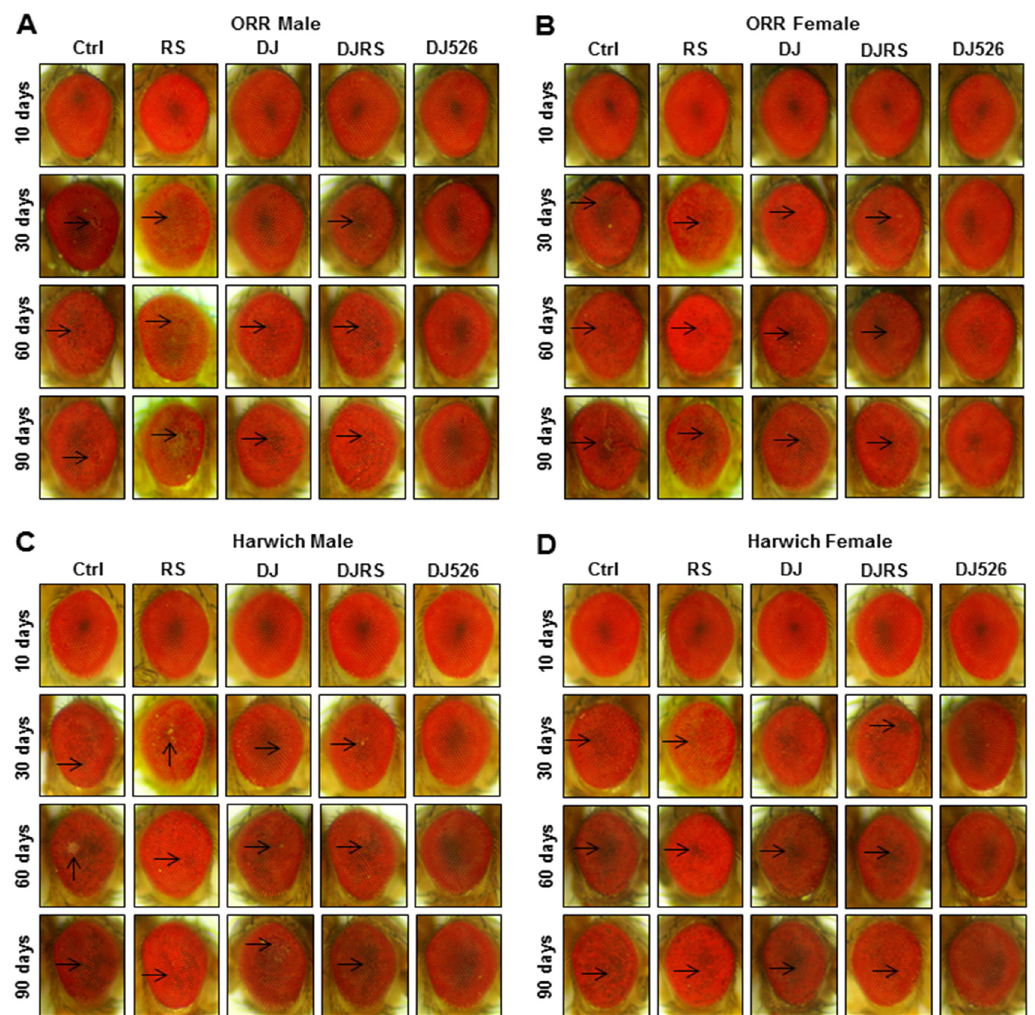
Figure 4. The resveratrol rice DJ526 suppressed the developmental eye defects in D. melanogaster . ( A ) ORR males, ( B ) ORR females, ( C ) Harwich males and ( D ) Harwich females with age progression. Ctrl represents standard cornmeal medium; RS represents cornmeal medium supplemented with resveratrol at 31.54 μ g/L, the equivalent amount of resveratrol found in the DJ526 media; DJ represents the medium in which 50% of cornmeal was replaced with Dongjin rice; DJRS represents the medium in which 50% of cornmeal was replaced with Dongjin rice and supplemented with resveratrol at 31.54 μ g/L, and DJ526 represents the medium in which 50% of the cornmeal was replaced with the resveratrol rice DJ526 (Table S1). Light microscopy studies of the Drosophila compound eyes were performed at the 10th, 30th, 60th and 90th days post ‐ eclosion, and the eye damages are indicated as arrows.